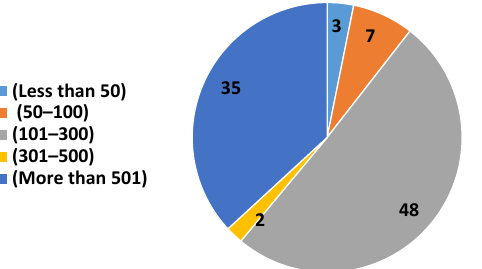
Figure 3. Number of the employees in the participants’ companies.